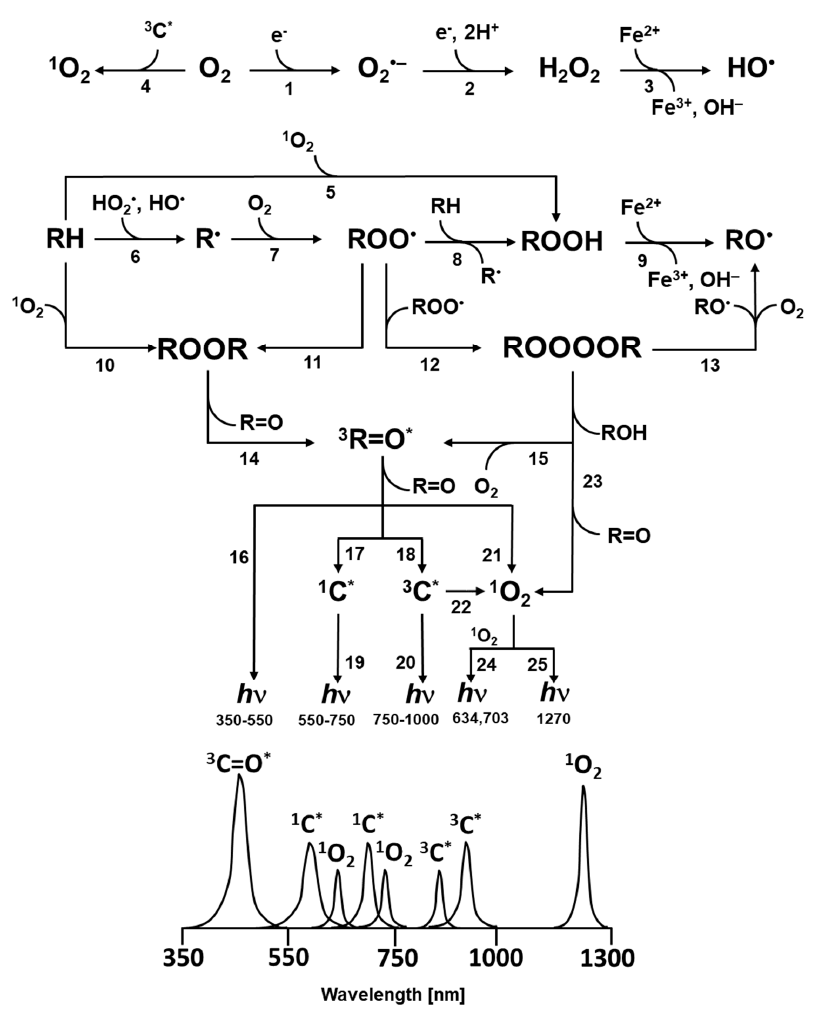
Figure 1. Mechanism of the formation of electronically excited species by oxidative metabolic processes. One-electron reduction of molecular oxygen by highly reducing species forms O 2 • - (reaction 1). The dismutation of O 2 • - generates H 2 O 2 (reaction 2), whereas the subsequent one-electron reduction of H 2 O 2 leads to the formation of HO • (reaction 3). The triplet-triplet energy transfer from triplet chromophore to molecular oxygen results in the formation of 1 O 2 (reaction 4). Formation of ROOH from R and 1 O 2 via ene reaction (reaction 5). The hydrogen abstraction from biomolecules (lipids, proteins and nucleic acids) (RH) by radical ROS (HO • , HO 2 • ) generates R • (reaction 6). The subsequent one-electron oxidation of R • brings about the formation ROO • (reaction 7). The consequent hydrogen abstraction from another R by ROO • forms ROOH (reaction 8). The one-electron reduction of ROOH results in the formation of RO • and OH - (reaction 9). ROOR is formed by either the cycloaddition of 1 O 2 (reaction 10) or the cyclization of ROO • (reaction 11). ROOOOR is formed by the recombination of two ROO • (reaction 12). The decomposition of ROOR (reaction 14) or ROOOOR (reaction 15) results in the formation of 3 R=O * . Alternatively, the decomposition of ROOOOR can lead to the formation of two RO • and O 2 (reaction 13). The electronic transition from 3 R=O * to R=O is accompanied by the photon emission (16). The energy transfer from 3 R=O * to chromophores results in the formation of 1 C * (reaction 17) and 3 C * (reaction 18) chromophores. The electronic transition from 1 C * and 3 C * to the ground state of chromophores is accompanied by the photon emission. (reaction 19, 20). The triplet-triplet energy transfer from 3 R = O * (reaction 21) and 3 C * (reaction 22) to molecular oxygen forms ( 1 O 2 ). Alternatively, the decomposition of ROOOOR via the Russell-type mechanism, results in 1 O 2 (reaction 23) with dimol photon emission (reaction 24) and monomol photon emission (reaction